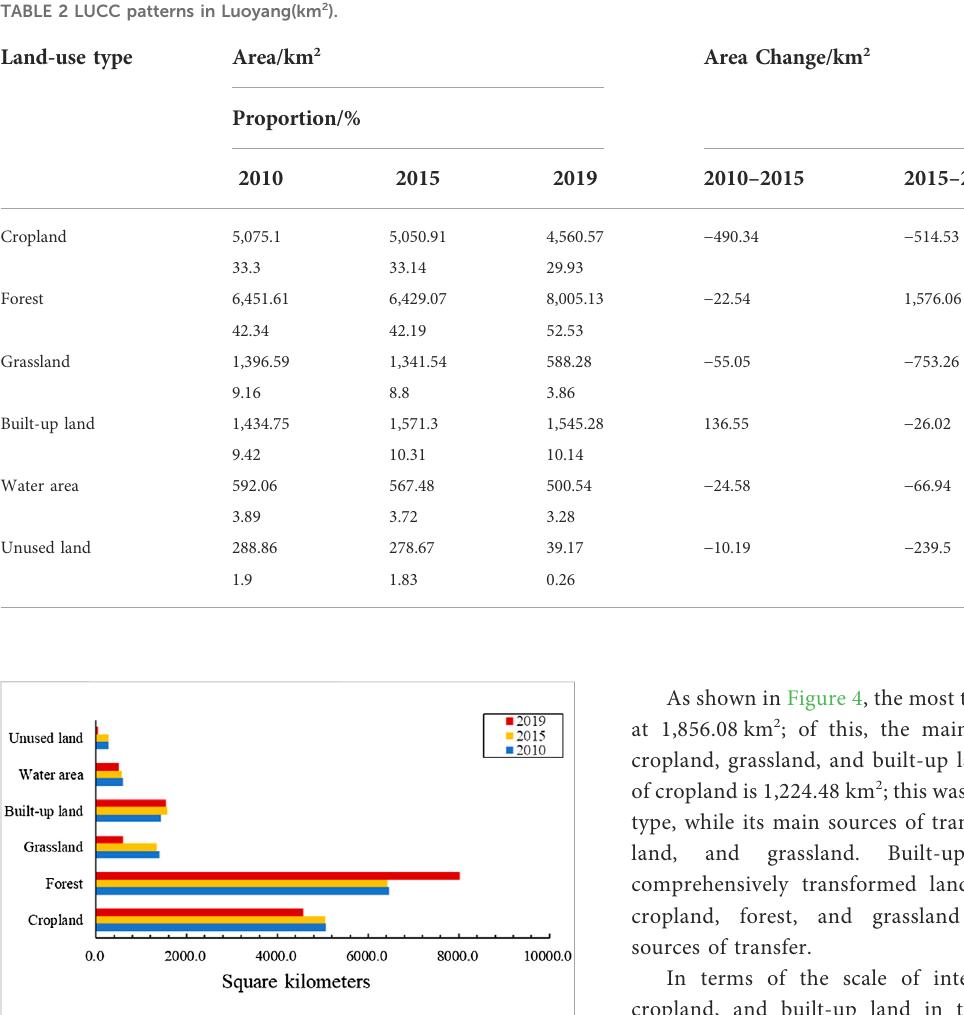
FIGURE 2 Area of each land-use type in Luoyang (km 2